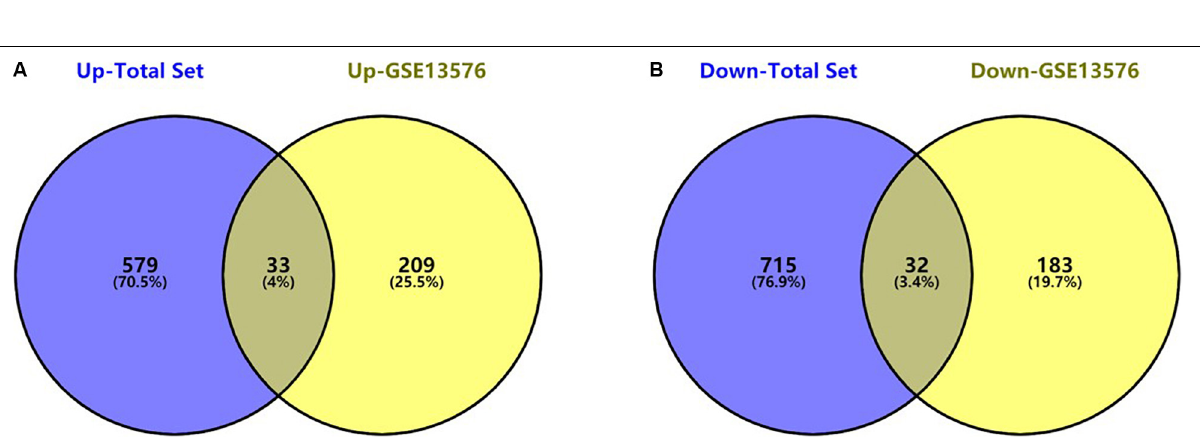
Frontiers in Oncology |